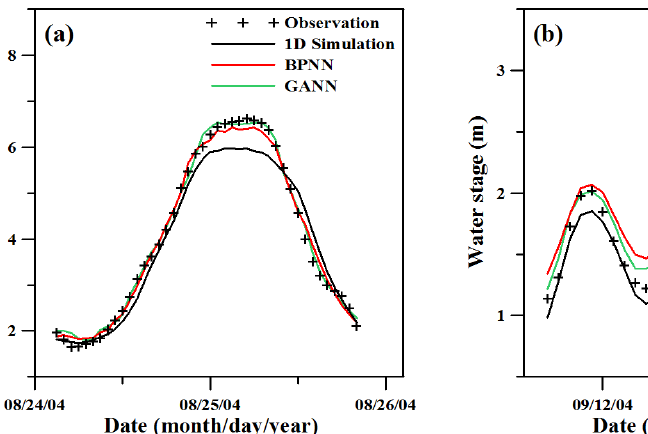
Figure 4. Comparison of observed and simulated water stages for the flood routing hydrodynamic model, BPNN and genetic algorithm neural network (GANN) model calibration at the Ru-Kuo-Yan station for: ( a ) Typhoon Aere (2004); ( b ) Typhoon Haima (2004); ( c ) Typhoon Nockten (2005); ( d ) Typhoon Matsa (2005); and ( e ) Typhoon Sepat